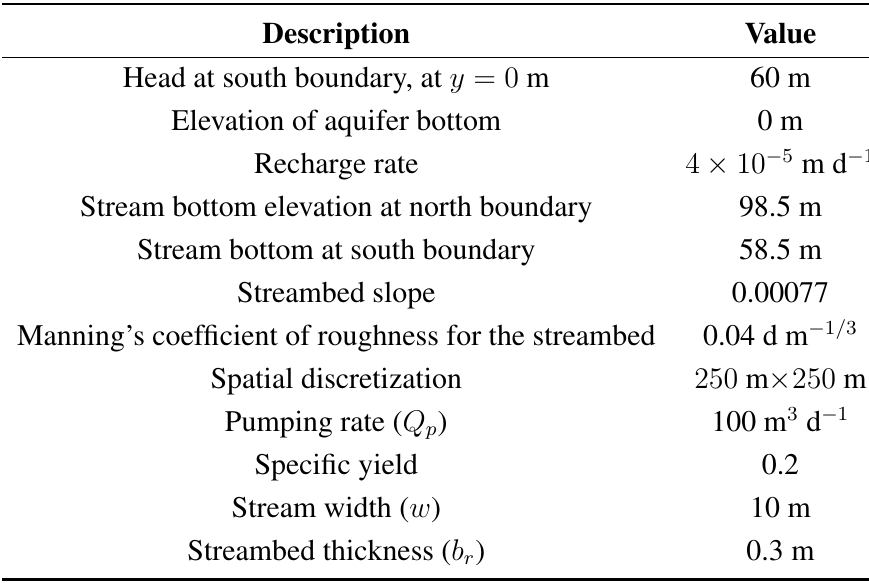
Table 1. Aquifer and model